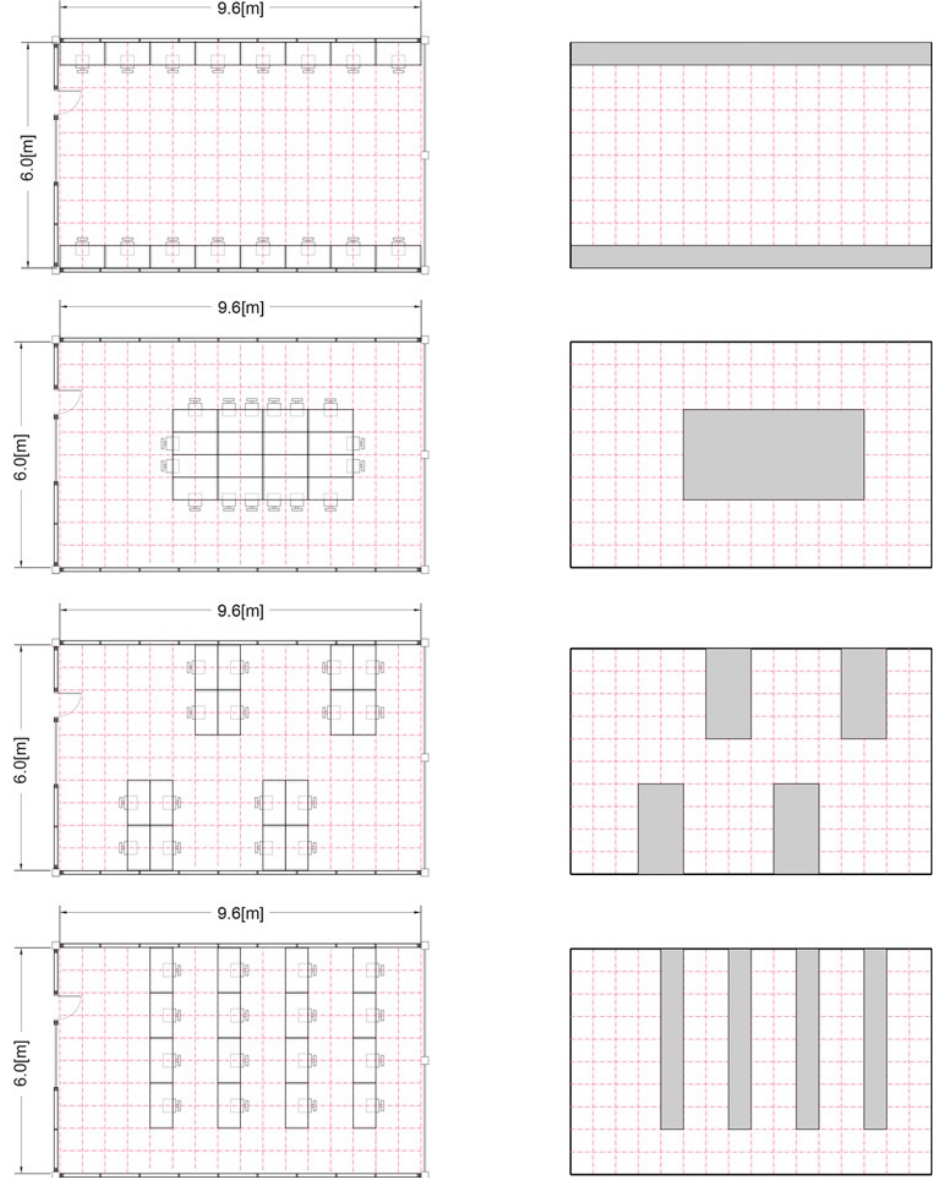
Figure 1. Floor plan and schematic representation of a typical classroom with four different furniture layouts.